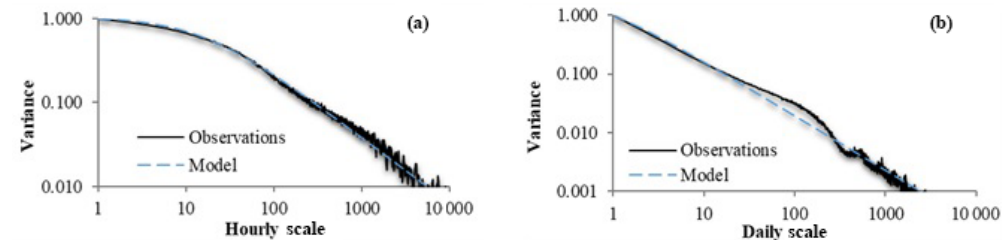
Figure 1. Wind speed climacogram (a) and precipitation (b)